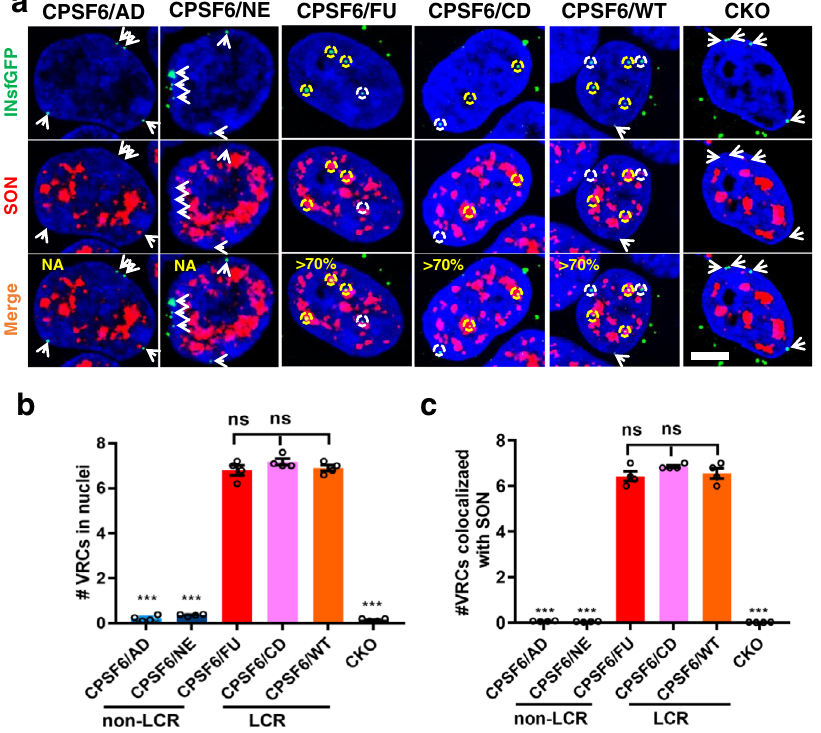
Fig. 3 | CPSF6 LCR effects on HIV-1 nuclear import and targeting to NS. a – c HEK293TCKOcellswereback-complementedwithindicatedHAtaggedCPSF6 (CPSF6) proteins and infected with VSV-G pseudotyped HIV-1 viruses (MOI 1) labeled with INsfGFP (green) for 4h. Cells were fi xed and immunostained for SON nuclear speckle (NS) marker (red) and nuclei with SiR-Hoechst (blue). a Single Z-stack images. Scale bar is 5 µ m. b Quantitation of the number of IN-labeled viral replicationcomplexes (VRCs)>0.5 µ m ofthe nuclearperiphery. c Quanti fi cation of IN-VRCs colocalized with SON-NSs. Mean values obtained from each experiment and SEM from a total of 4 independent experiments are shown in b , c . Each inde- pendent experiment analyzed >30 nuclei for each construct.